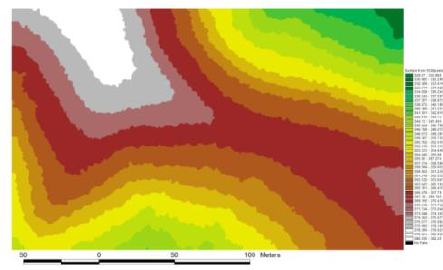
Figure 6. DEM created from reduced LiDAR data down to point cloud density of 0.128pts/m 2 .